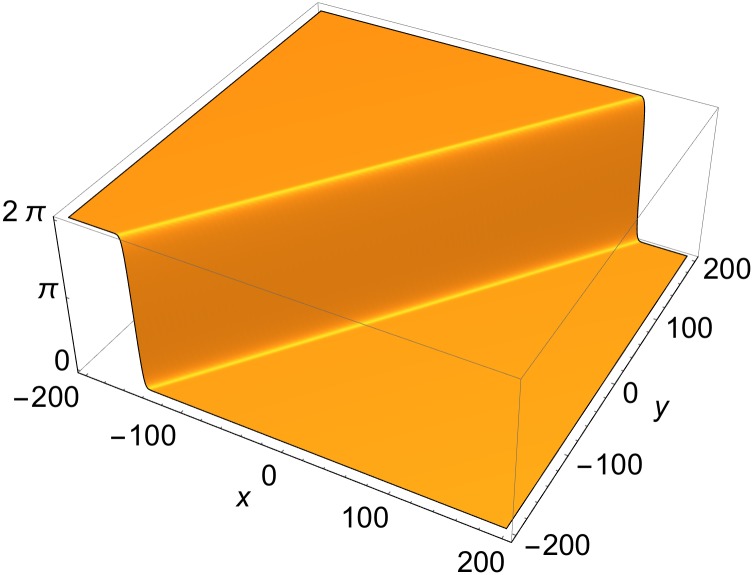
Single-front solution of Eq (1) in rest frame.p = {0, cosφ, sinφ, 0}; φ = −π/5; δ = 0.